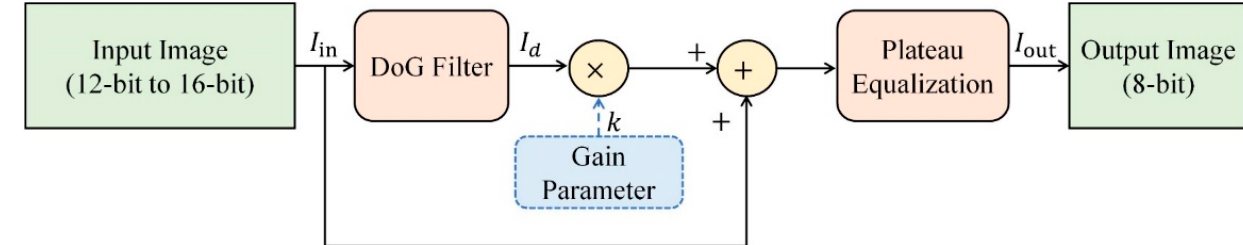
Figure 2. Framework of proposed method.